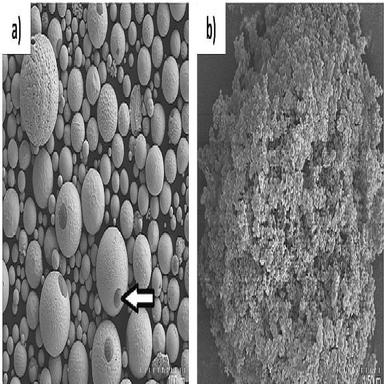
SEM morphologies of a) the separated larger and b) smaller particles of the Al-Mo system. The arrow indicates an example of an Al spot trying to diffuse to Mo.